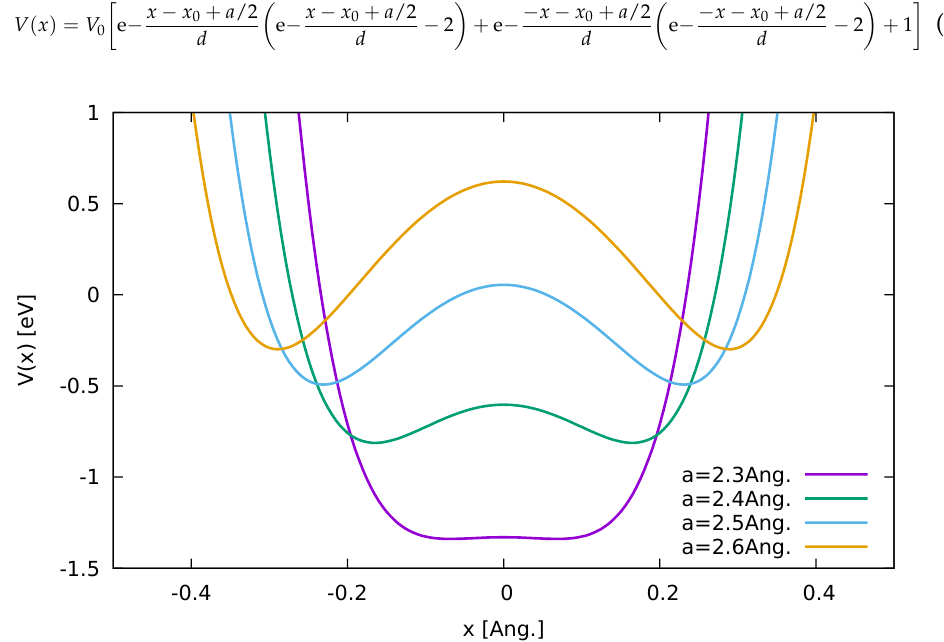
Figure A1. Double–well potential. The potential V ( x ) in (A7) for several distances a